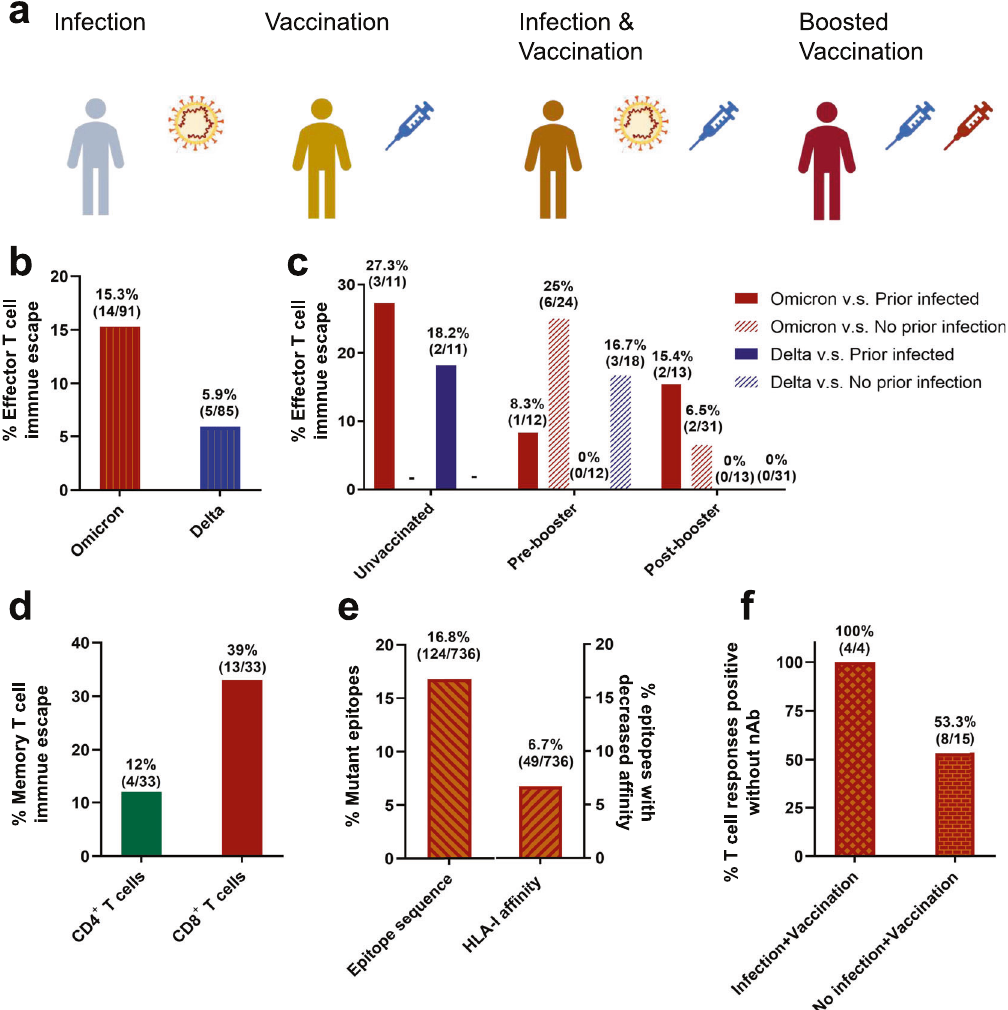
Fig. 1 Characteristics of SARS-CoV-2-speci fi c T-cell immune responses towards Omicron variant. a Schematic presentation of four main groups of included participants with different SARS-CoV-2 infection or vaccination statuses. Previously infected individuals, solely vaccinated individuals, infected and initially vaccinated individuals, vaccinated and boosted individuals were selected for SARS-CoV-2-speci fi c T-cell immune responses analysis. b , c Effector T-cell reactivity to the SARS-CoV-2 Omicron and Delta variants. The percentage of individuals whose effector T-cell response was escaped from by the Omicron or Delta variant was analyzed for the general population ( b ) and for the groups with no vaccination, pre-booster, and post-booster vaccination with or without an infection history ( c ). Effector T-cell immune escape was de fi ned as the individual who show a > 50% (0.3 log 10) reduction in effector T-cell response towards antigens from Omicron or Delta. d , e Memory T-cell immune escape and potential mechanism. CD4 + T-cell- and CD8 + T-cell-speci fi c carboxy fl uorescein succinimidyl ester (CFSE) proliferation assay results showed that CD4 + memory T cells had robust proliferative responses against Omicron spike, but escape from CD8 + memory T-cell responses were more frequent ( d ). Sequence alignment or binding af fi nity analysis for HLA class I epitopes predicted by NetMHCpan4.1 con fi rmed the mutations in epitope sequences and the decrease in HLA class I binding af fi nity ( e ). f Effector T-cell responses to Omicron are preserved even in individuals without detectable neutralizing antibodies of Omicron. A portion of vaccinated individuals with or without prior infection was T-cell response-positive but neutralizing antibody-negative from IFN- γ ELISpot and pseudovirus neutralization assay. The data ( b – f ) are reproduced from the original article and supplementary materials. Panels b – f are adapted from fi gures and data in the article by Naranbhai et al.